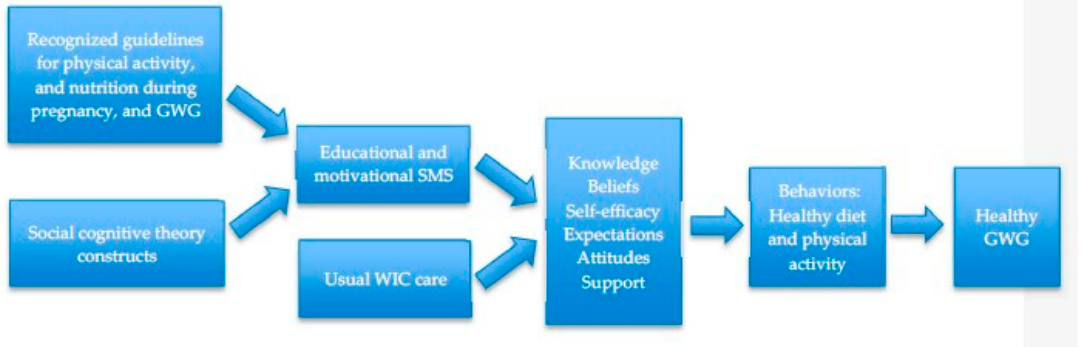
Figure 1. Theory of change diagram for using short message service (SMS) in prevention of excessive gestational weight gain (GWG).